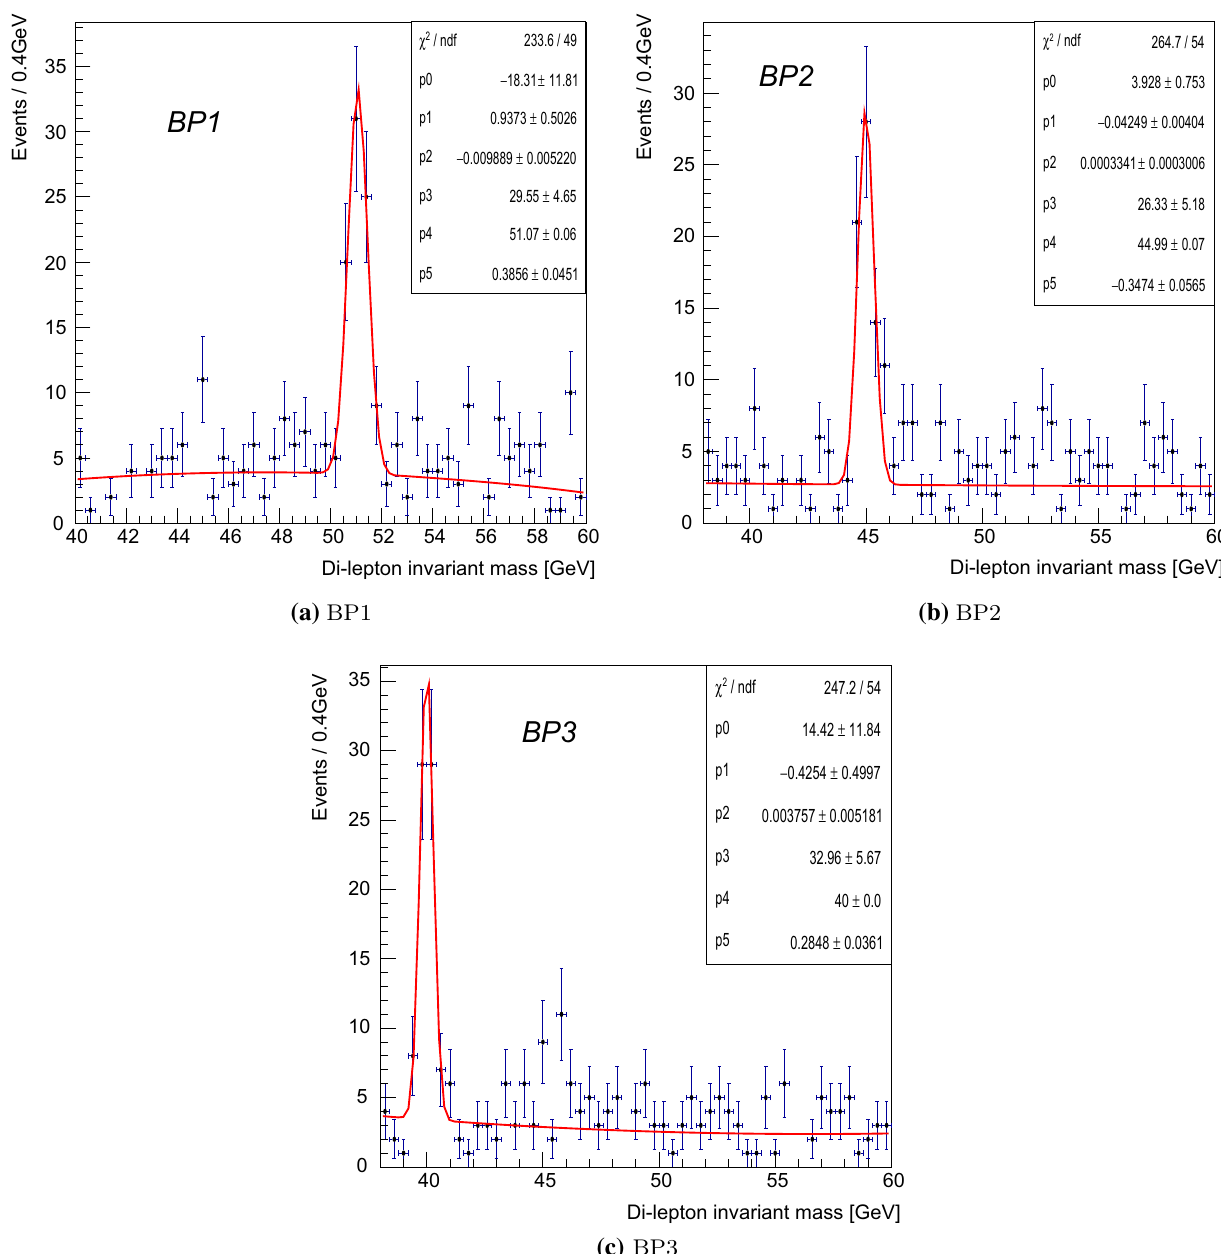
Fig. 13 The pseudo-data of di-lepton invariant mass in signal ( (cid:2)(cid:2) HjjH ) and background events and the fit to the total